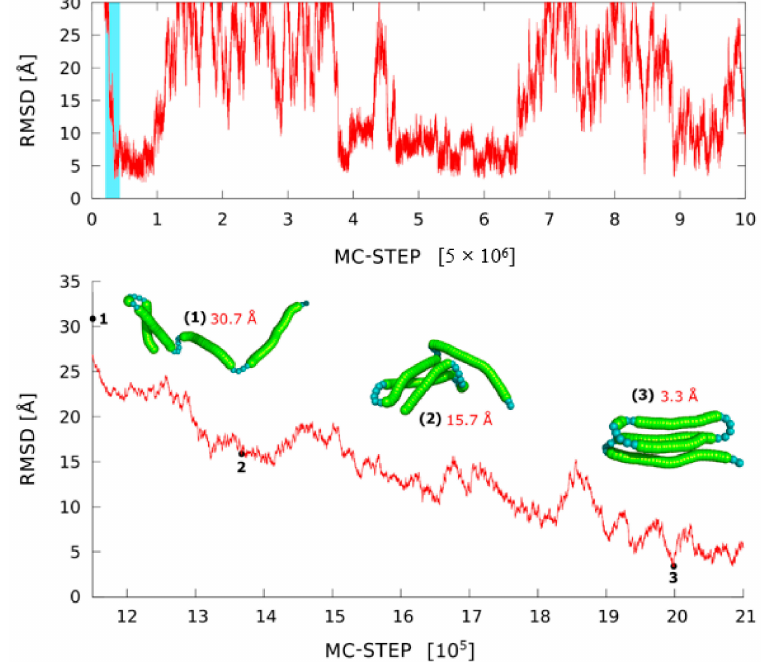
Figure 8. MC dynamics trace for a single replica for alpha protein (PDB code: 1k40) in SURPASS representation. The lowest panel shows the enlargement of the coil-to-globule transition taken from a small fragment of the RMSD trajectory marked in blue in the upper plot. The selected snapshots of protein structures illustrate the observed mechanism of fold